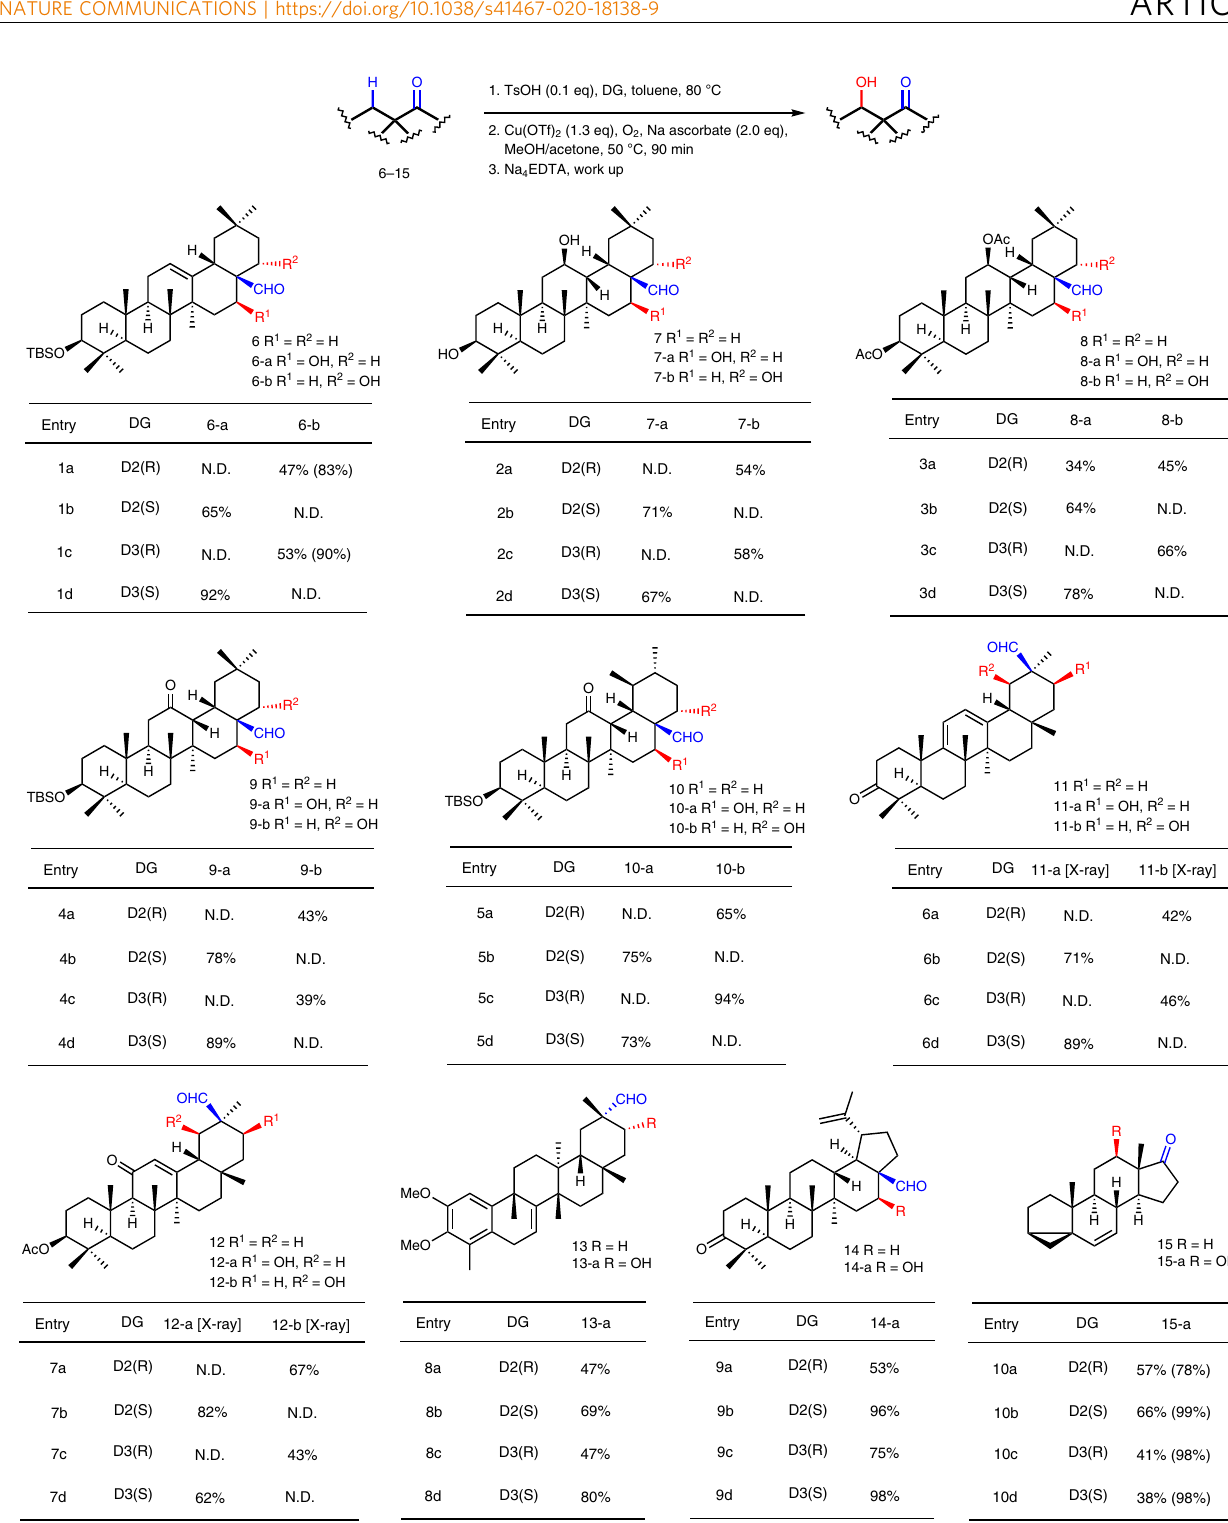
Fig. 3 Scope of the site-selective C-H hydroxylation of PT derivatives. The yield in parentheses are based on recovered starting materials. In entries 5c, 5d, and 9a-d, during working up, the mixture was treated with Na 4 EDTA and followed with 1 N HCl for 1 h. Ac acetyl, N.D. not